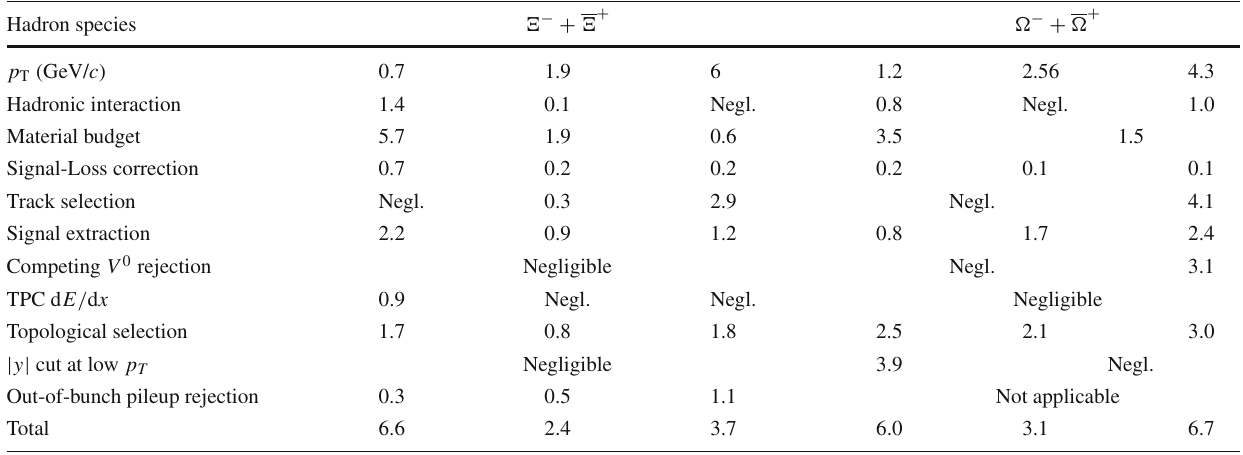
Table 6 Summary of the main sources and values of the relative sys- tematic uncertainties (expressed in %) for the (cid:6) − + (cid:6) p T -differential yields. A single value between two or three columns